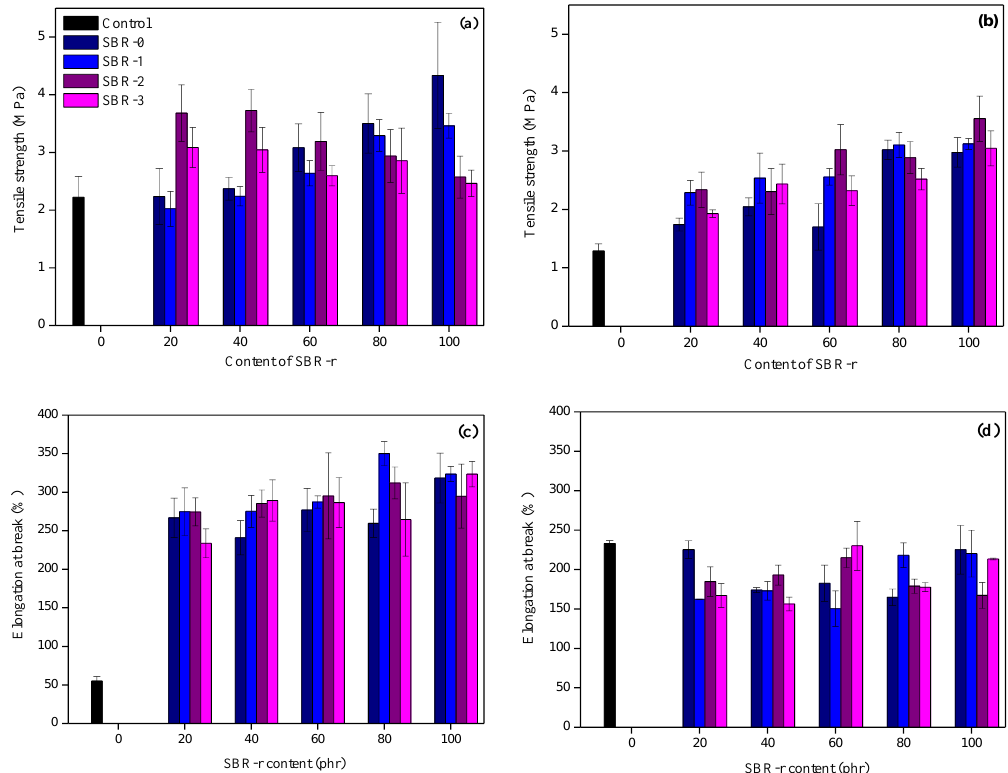
Figure 2. Results of tensile strength and elongation at break for the SBR-r composites. ( a , c ) before accelerated aging; and ( b , d ) after accelerated aging in an air oven.